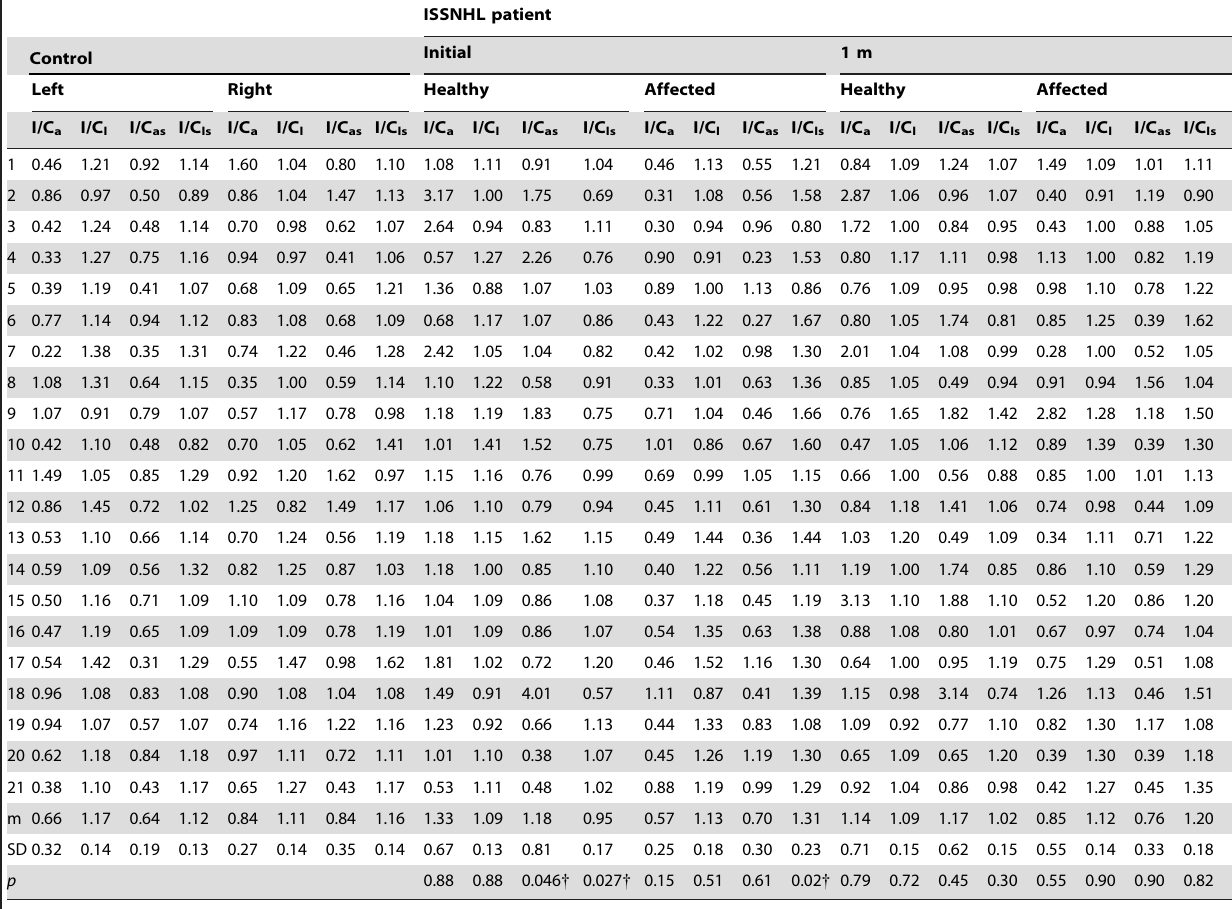
Table 4. Ipsilateral/contralateral ratio of